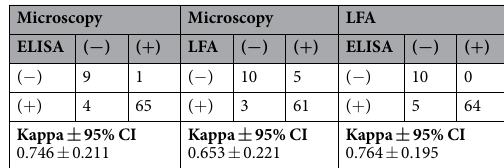
Table 1. Kappa coefficient analysis of the correlation between the employed diagnostic methods (microscopy, ELISA,